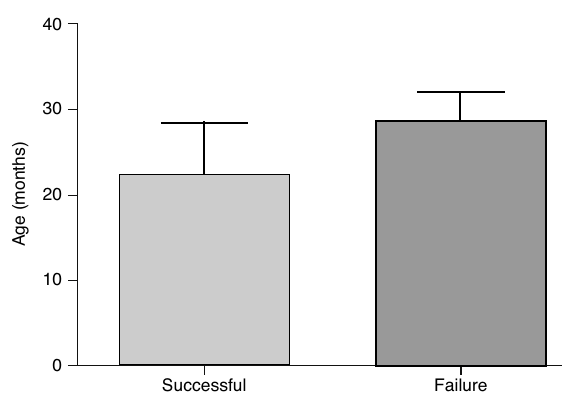
Figure 5 Correlation between patient age and success of bal- loon laryngoplasty.